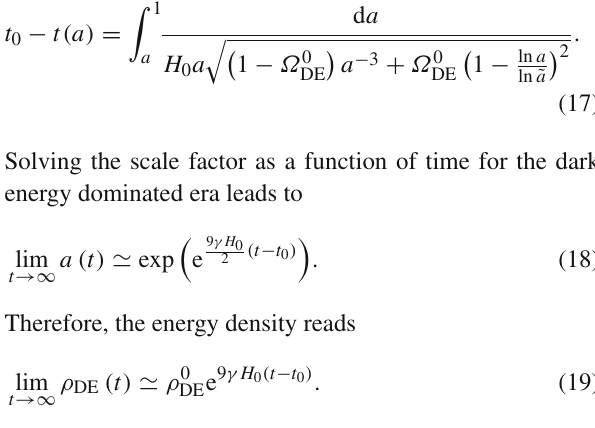
Fig. 3 Scale factor as a function of ( t − t 0 ) H 0 for various values of the viscous coefficient. Other free parameters have been fixed by SNIa observational constraint. The Λ CDM best fit is given by the Planck